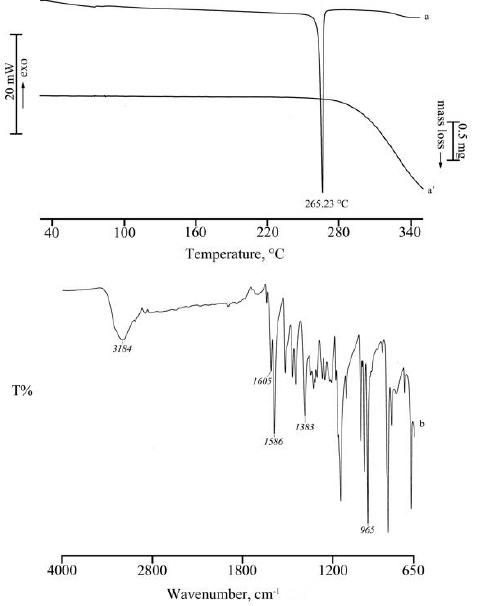
Figure 2. DSC and TGA curves ( a , a’ ) and FT-IR spectrum ( b ) of commercial RSV.